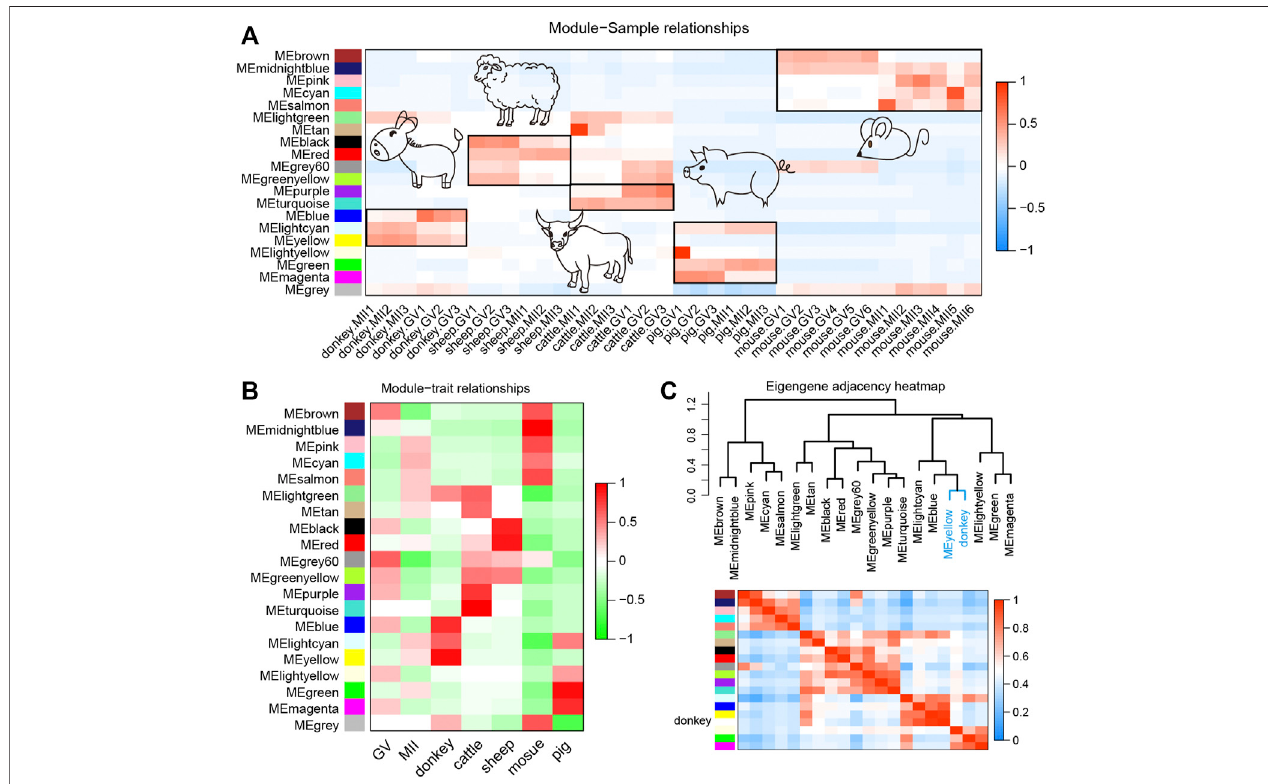
FIGURE 5 | Weighted gene co-expression network analysis (WGCNA) of oocyte development during the period from germinal vesicle (GV) to metaphase II (MII) in different species. (A) The heat map shows the correlation between different samples and functional modules identi fi ed by WGCNA. (B) The heatmap shows the correlation between different phenotypes and functional modules identi fi ed by WGCNA. (C) The correlation between donkey and functional modules identi fi ed by WGCNA. The yellow functional module is the key functional module involved in donkey oocyte